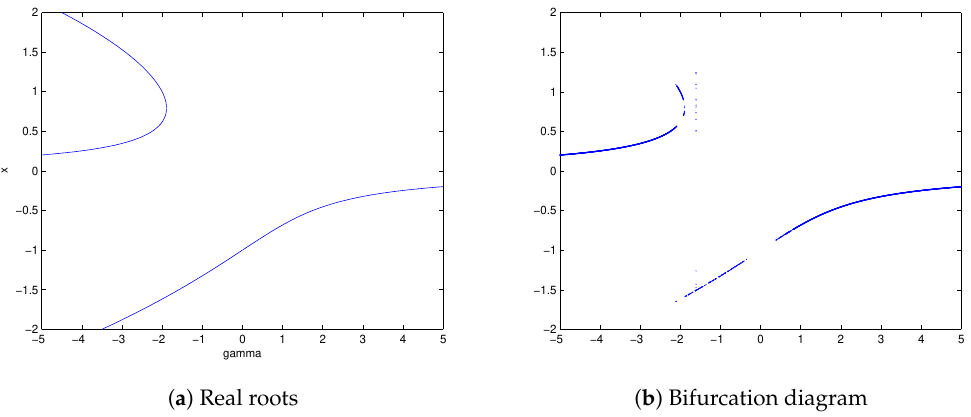
Figure 1. Comparison between the real roots and the iterative